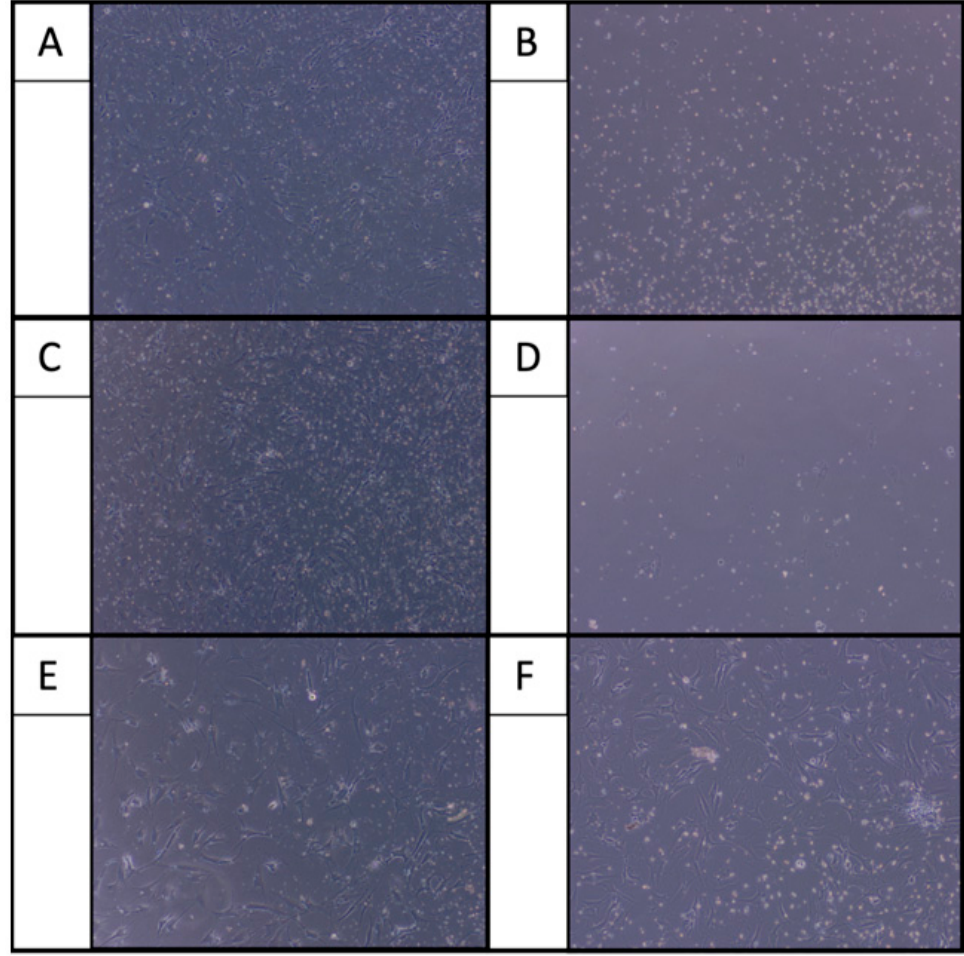
Figure 3. Adding GC to bupivacaine ( B ) and lidocaine ( D ) showed reduced cell adherence. Adding HA to GC (GC/HA) showed better cell adherence for bupivacaine ( A ) and lidocaine ( C ). Ropivacaine with GC ( F ) and GC/HA ( E ) showed best cell adherence.